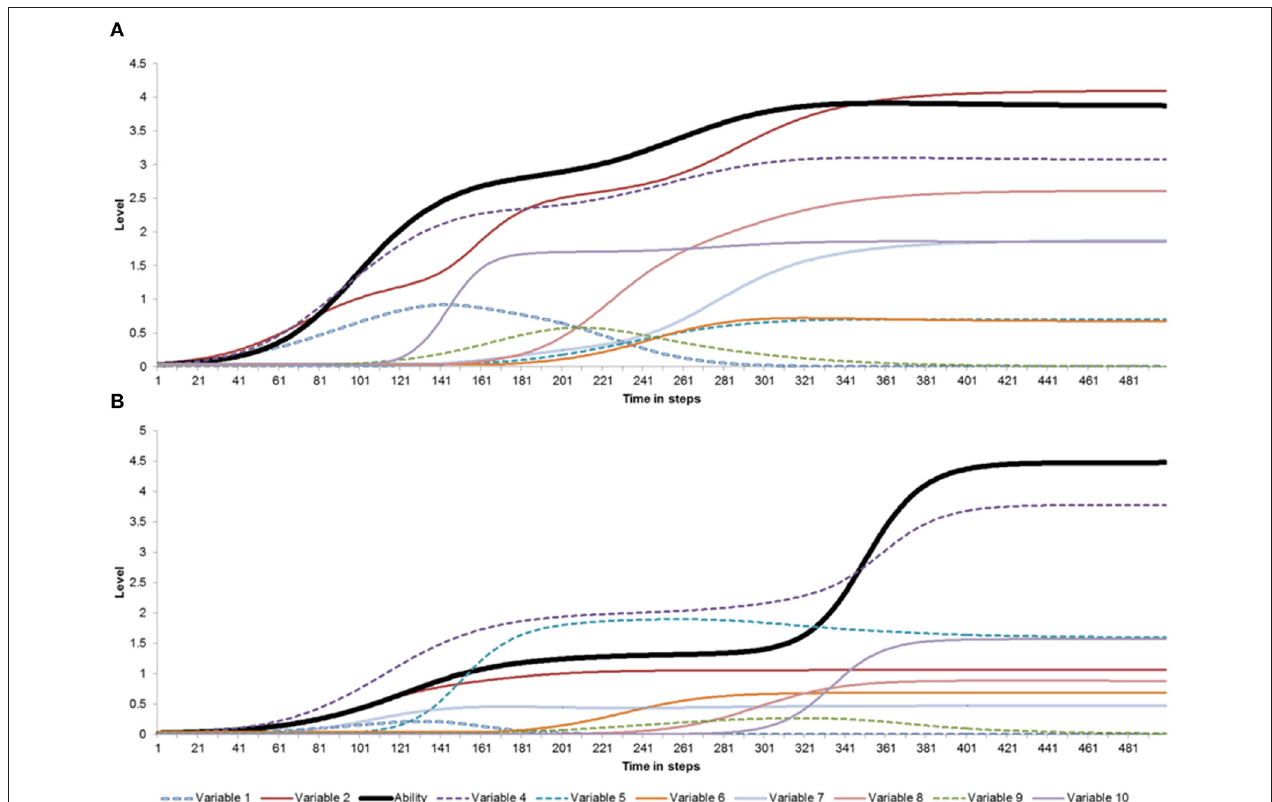
FIGURE 6 | Simulations of two idiosyncratic networks of individuals who reach high ability levels. The black solid line represents the ability, whereas the other variables represent the dynamic network components that have supportive, competitive, or neutral relationships with the ability component. For individual (A) the initial ability L is 0.028; the maximum value of L (Max L ) = 3.91; the resource consumption rate r is 0.04; the genetic factor K is 1.15; and the total support is 0.07. For individual (B) the initial ability L is 0.02; the maximum value of L (Max L ) is 4.48; the resource consumption rate r is 0.03; the genetic factor K is 1.17; and the total support is